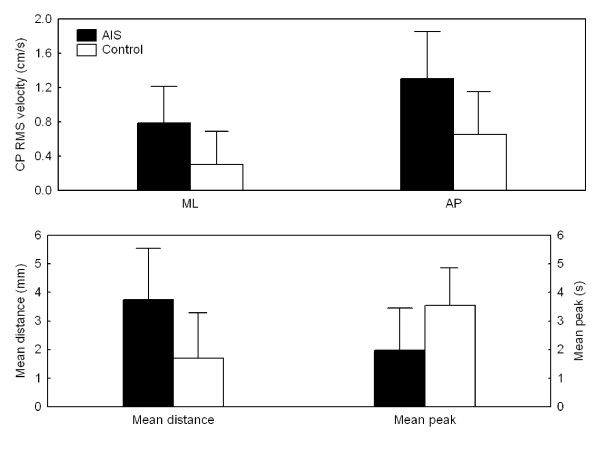
Balance control performance in absence of sensory inputs manipulation. Upper panel – Group means for the CP RMS velocity along the medio-lateral (ML) and antero-posterior (AP) axes for the control condition. Lower panel – Groups means of the distance between consecutive zones of stability (mean distance – left vertical axis) and the time spent within the zones of stability (mean peak – right vertical axis) for the control condition. On both panels, the error bars indicate 95% confidence intervals.